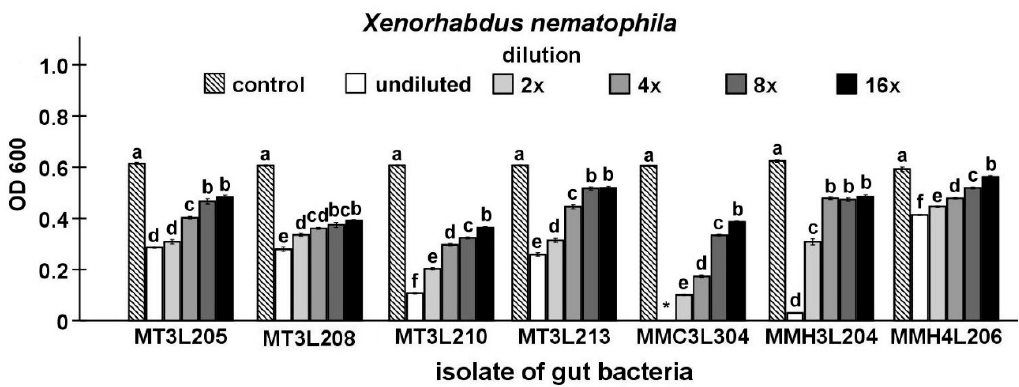
Figure 6. Antagonistic activities of different dilutions of culture supernatants from selected M. melolontha midgut isolates against X. kozodoi shown by MID tests. The same letters mean no significant differences between the activities of supernatants from the same midgut isolate.